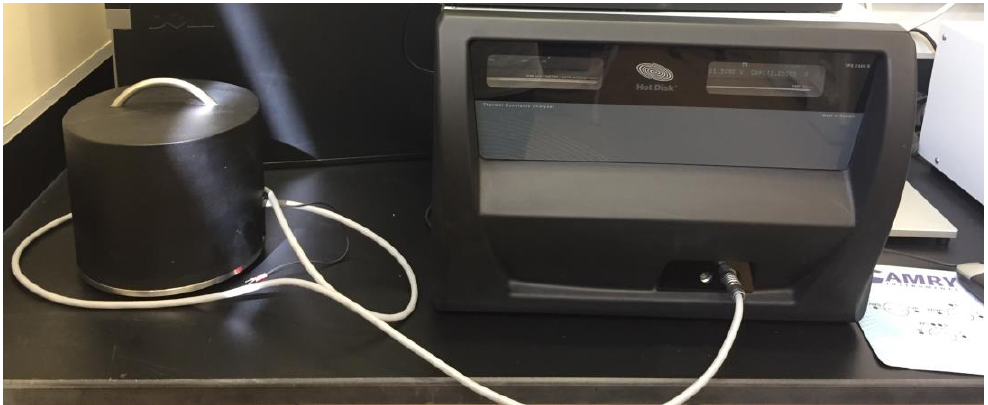
Figure 4. Hot Disk TPS 2500s thermal analyzer .